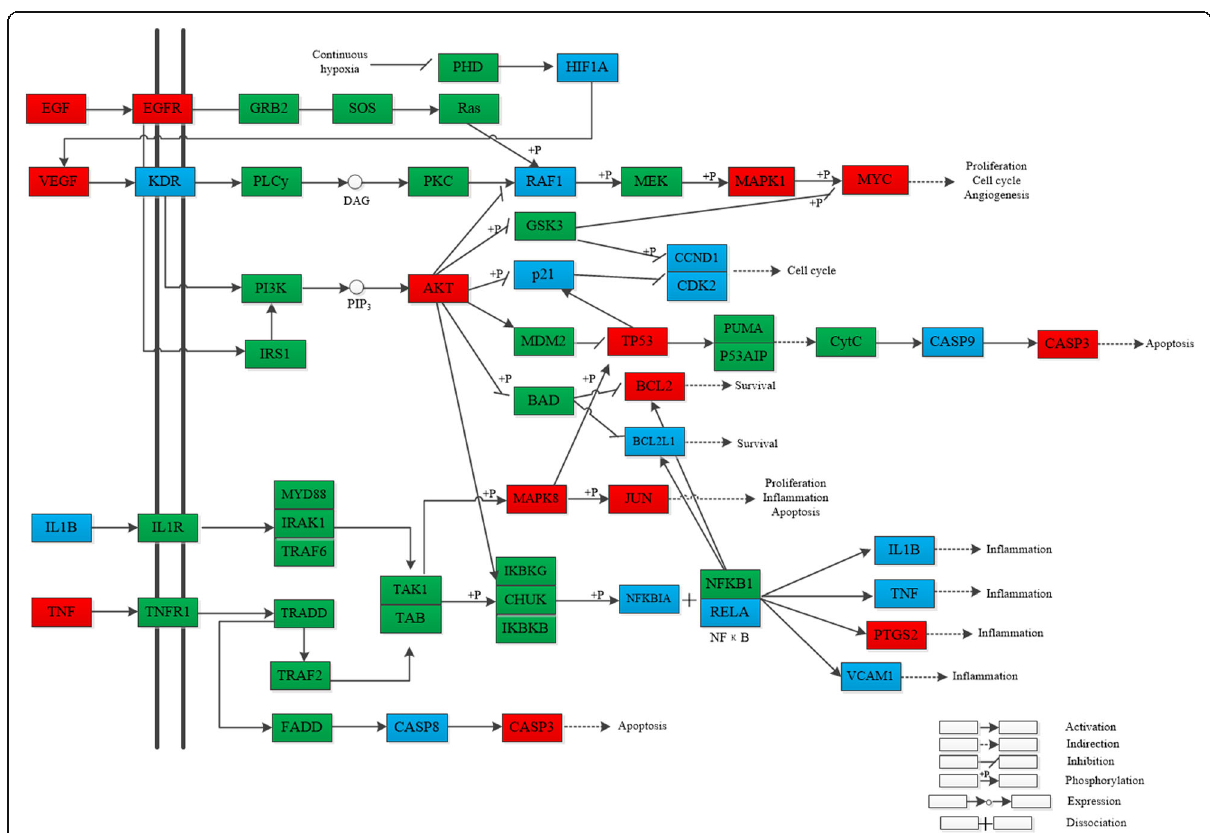
Fig. 9 The anti-pancreatic cancer pathway of Wumei Pill. The red nodes represent the big hub nodes, the blue nodes represent the other nodes, and the green nodes represent the targets in the